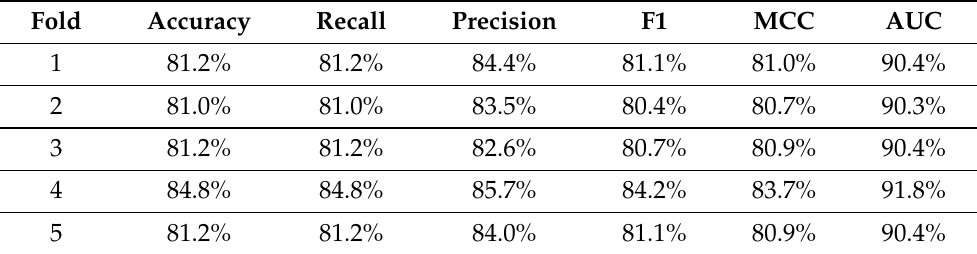
Table 4. Result of five-fold cross-validation. The F1 score is the weighted F1 score and the MCC is the Matthews correlation coefficient, which was obtained as the average of the MCC for each class. This metric tables were written by referring to [68,69].